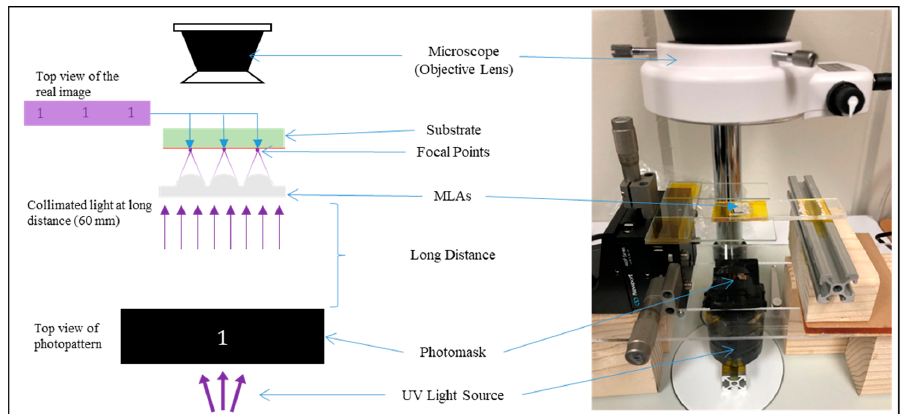
Figure 8. Projection lithography scheme.